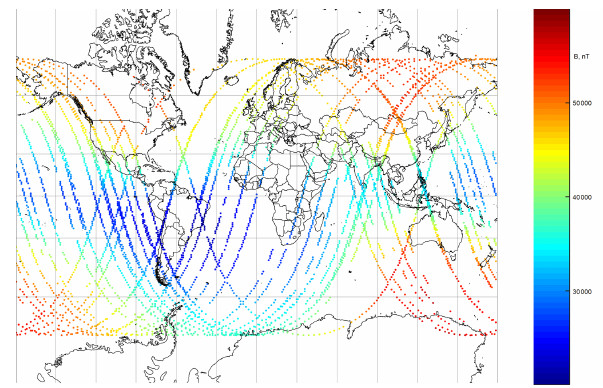
Figure 12. Kosmos-321 measured magnetic